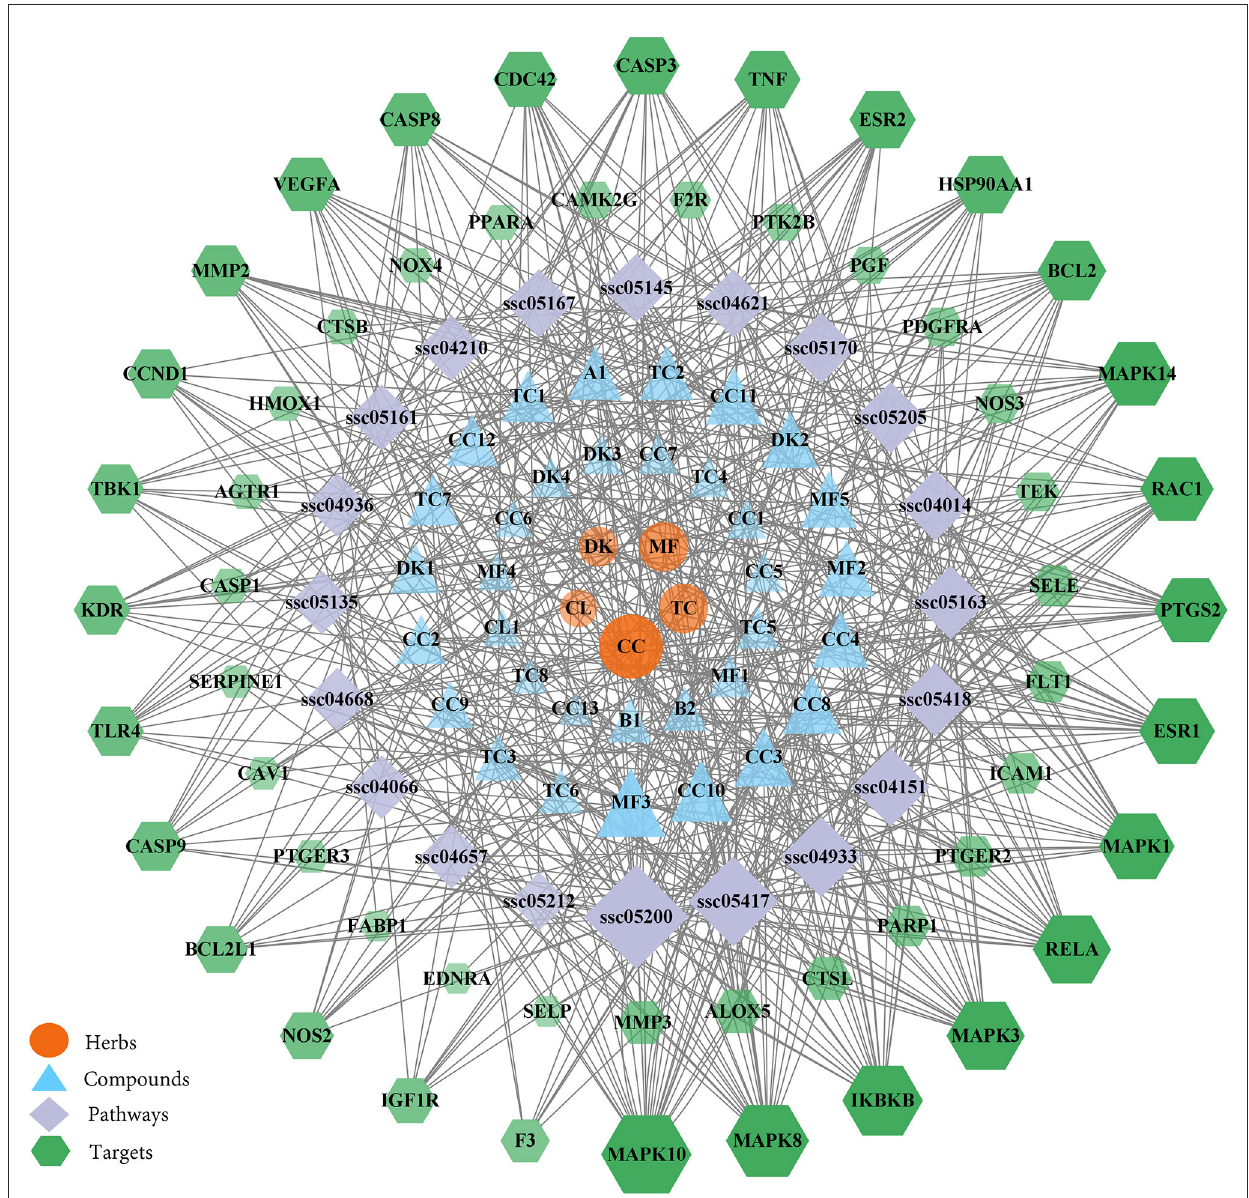
FIGURE6 The herb-compound-disease target-pathway network. The orange ellipse, blue triangle, purple diamond, and green hexagon correspond to herbs, compounds, pathways, and target genes, respectively.